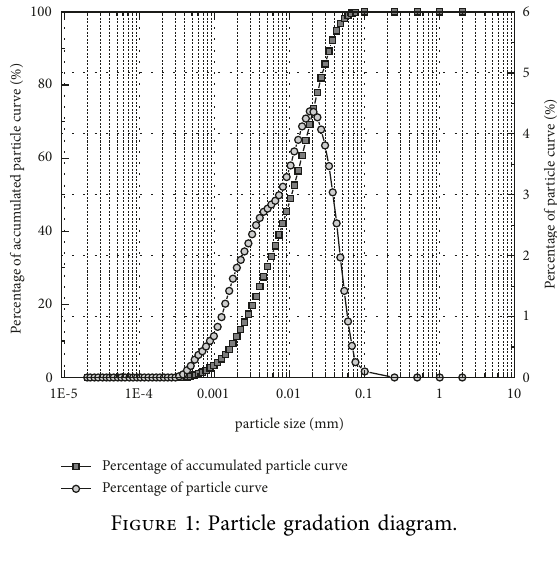
Figure 1: Particle gradation diagram.